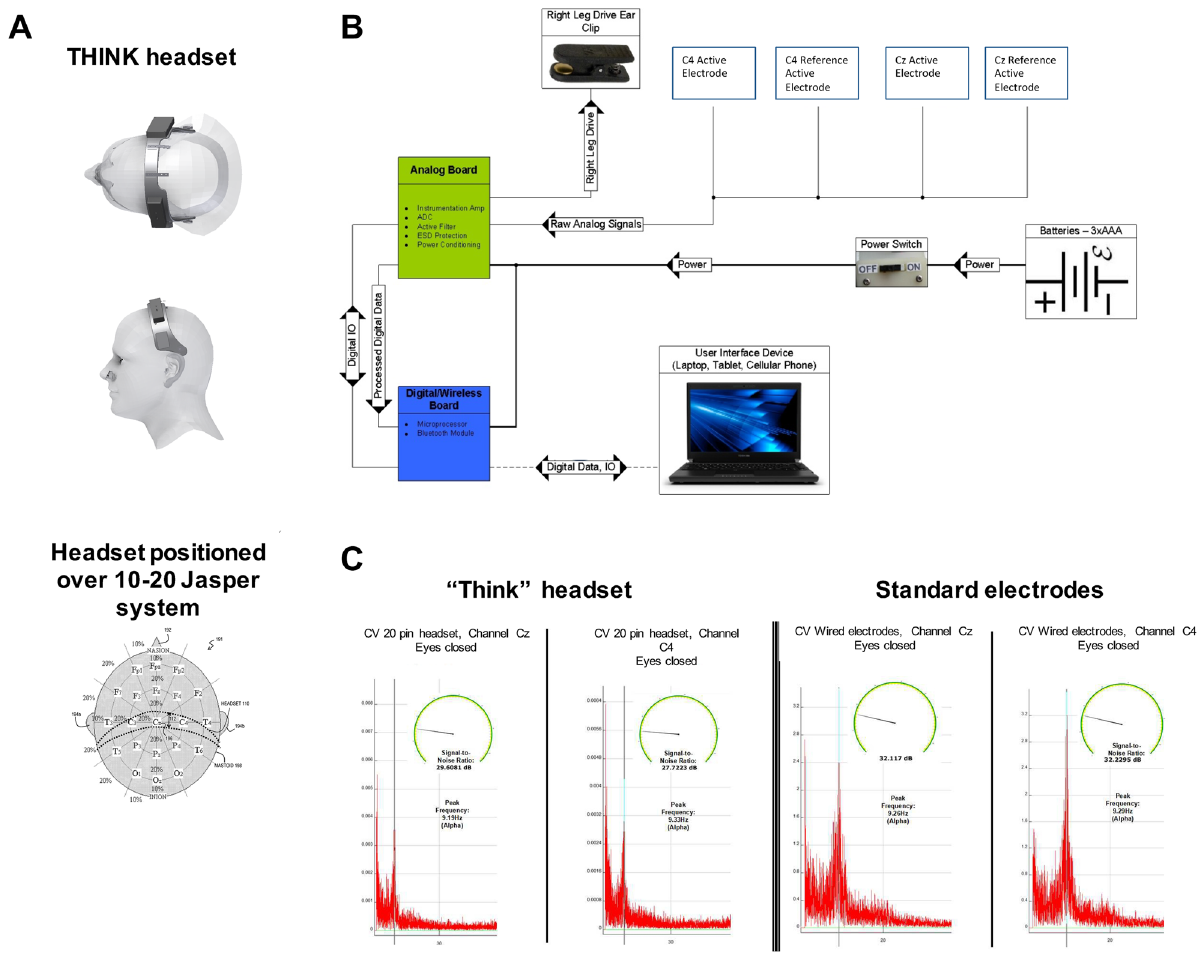
Figure 1. device presentation, positioning, chip and signal validation. ( A ) THINK headset as positioned on a human head, with a reference to the international 10–20 Jasper system. ( B ) System block diagram, showing the integration of analog board and digital process control block. The chip sending the signal to the analog board is encased in the headset shown in panel ( A ). ( C ) Comparison of the signal at Cz and C4 electrode location between THINK headset and Wired Ag/AgCl electrodes, of eyes closed, showing alpha frequencies (9.22 Hz) and signal to noise